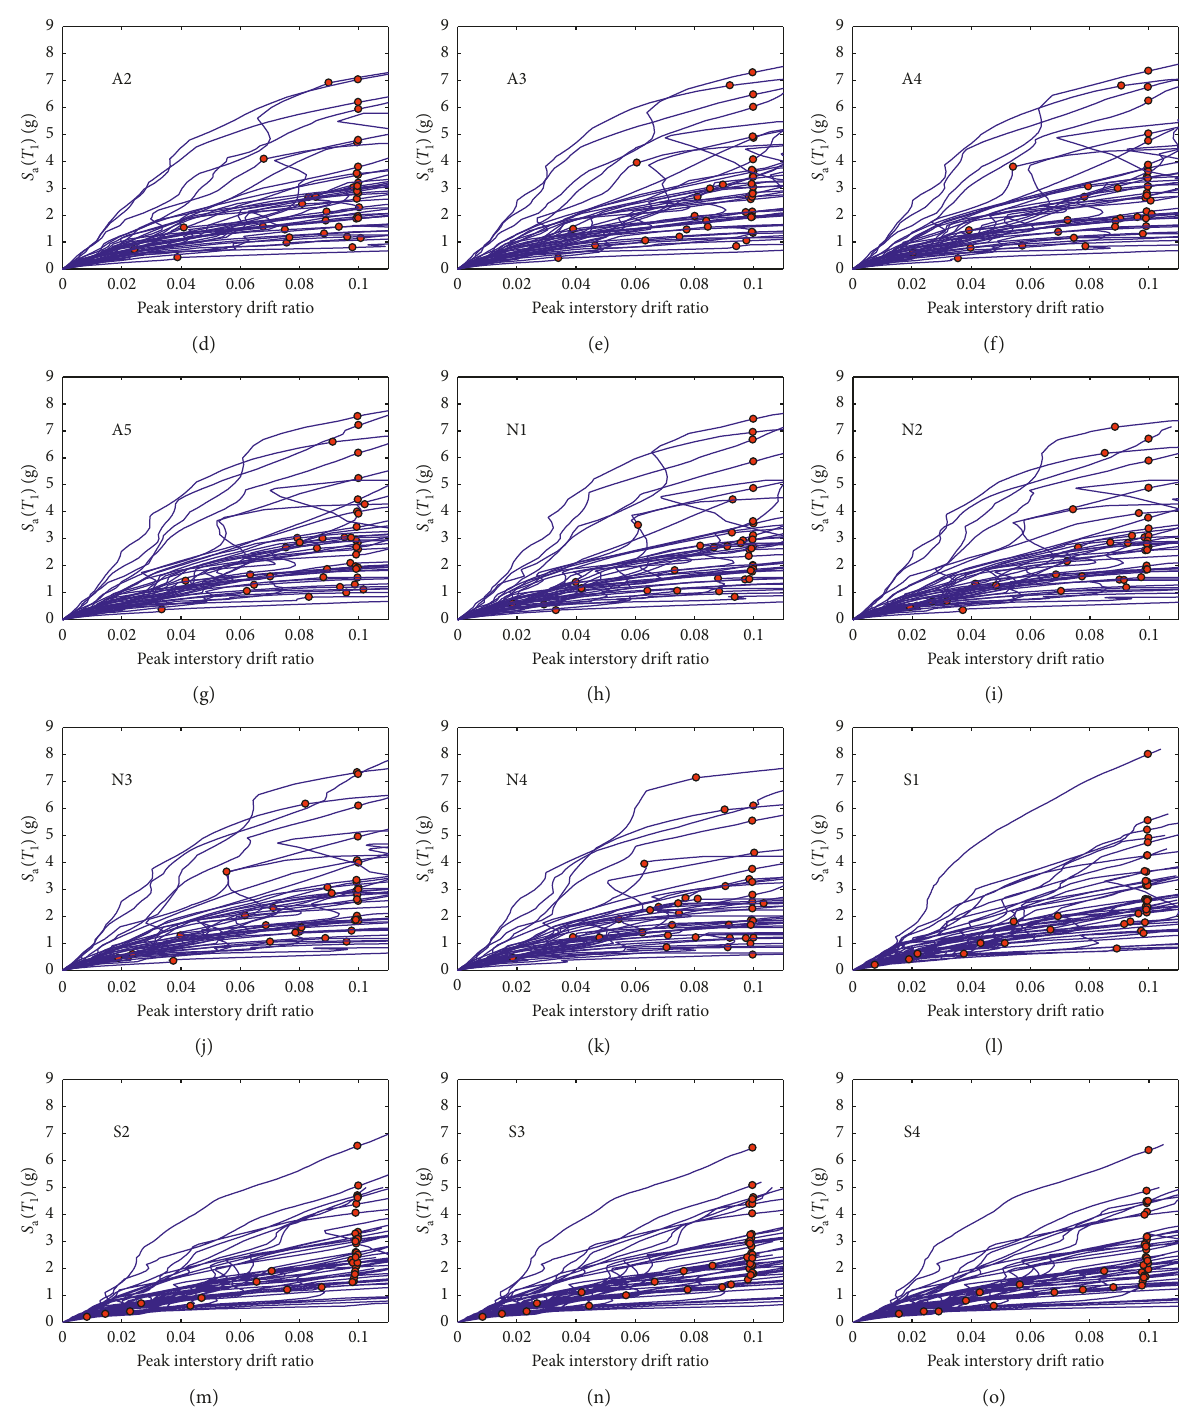
Figure 5: IDA curves of the poor building and different support